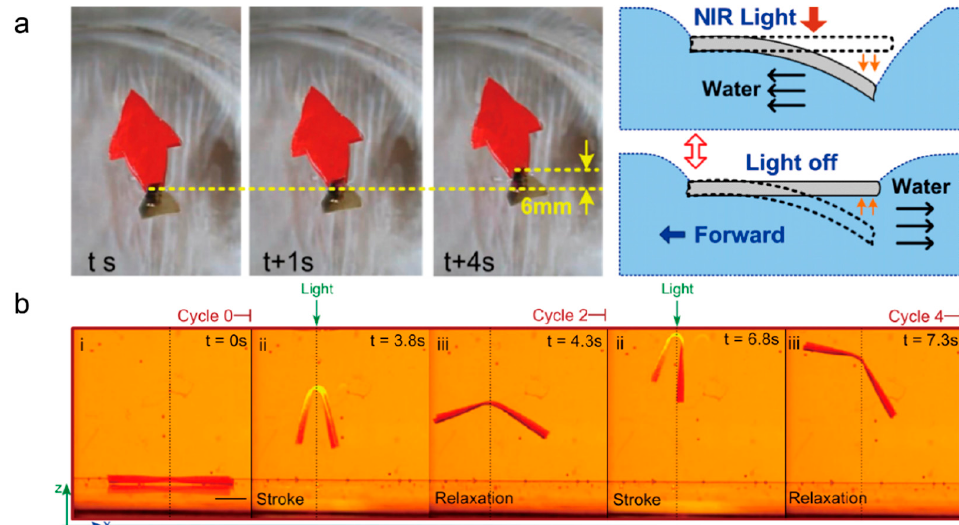
Figure 13. ( a ) Light-driven swimming of a soft robot based on an LCE film coated with PDA, and the schematic diagram of its actuation principle (Reprinted with permission from Ref. [35].